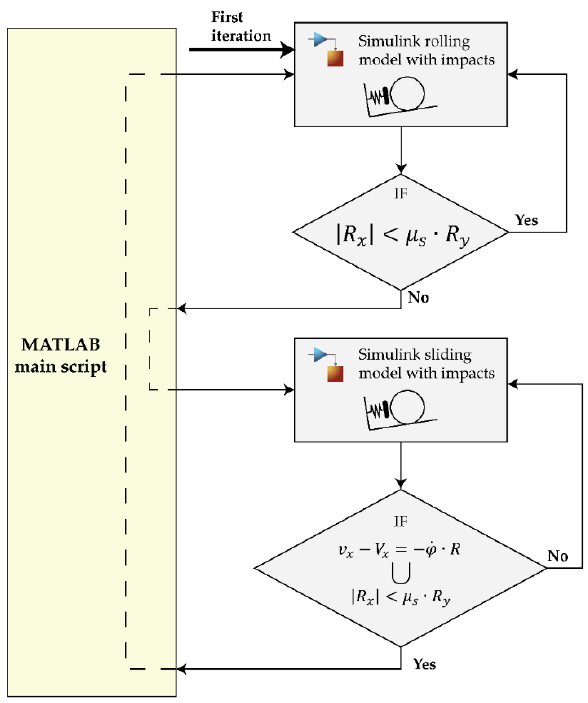
Figure 5. Logical flow of the simulation.